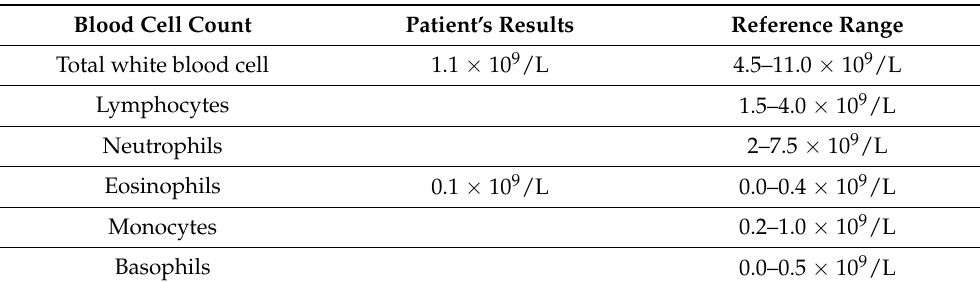
Table 2. Patient blood cell count.